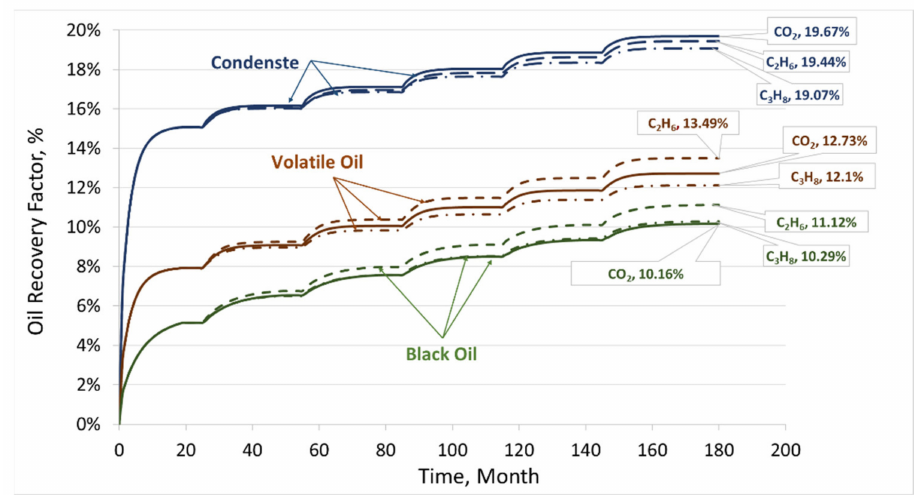
Figure 6. The increase in oil recovery associated with different injection gas when adsorption, diffusion, and hysteresis are